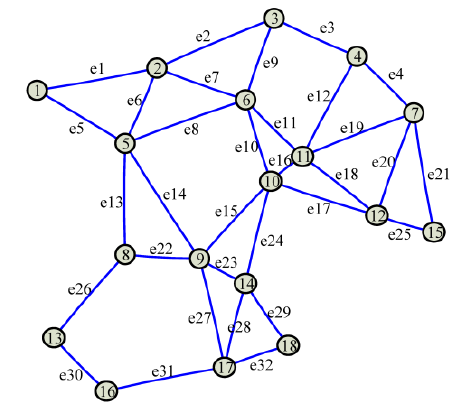
Figure 6. The associated graph of the mesh architecture in Figure 1d. The sensor nodes are denoted as circles, in which the numbers are the indexes of the associated nodes. Communication links within the neighboring ranges are represented by solid lines, and the indexes of these edges are given aside